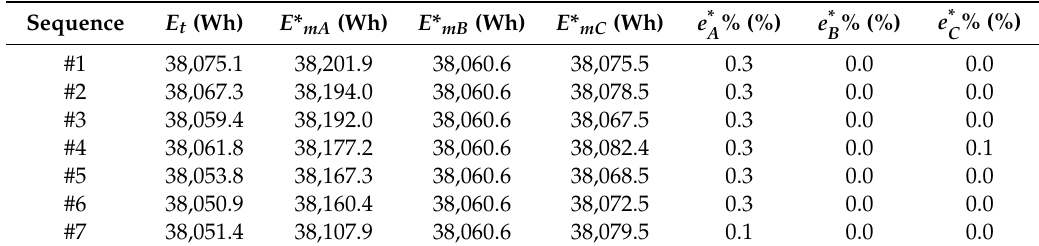
Table 9. EMUTs additional percentage error with random time-varying harmonic distorted current and voltage